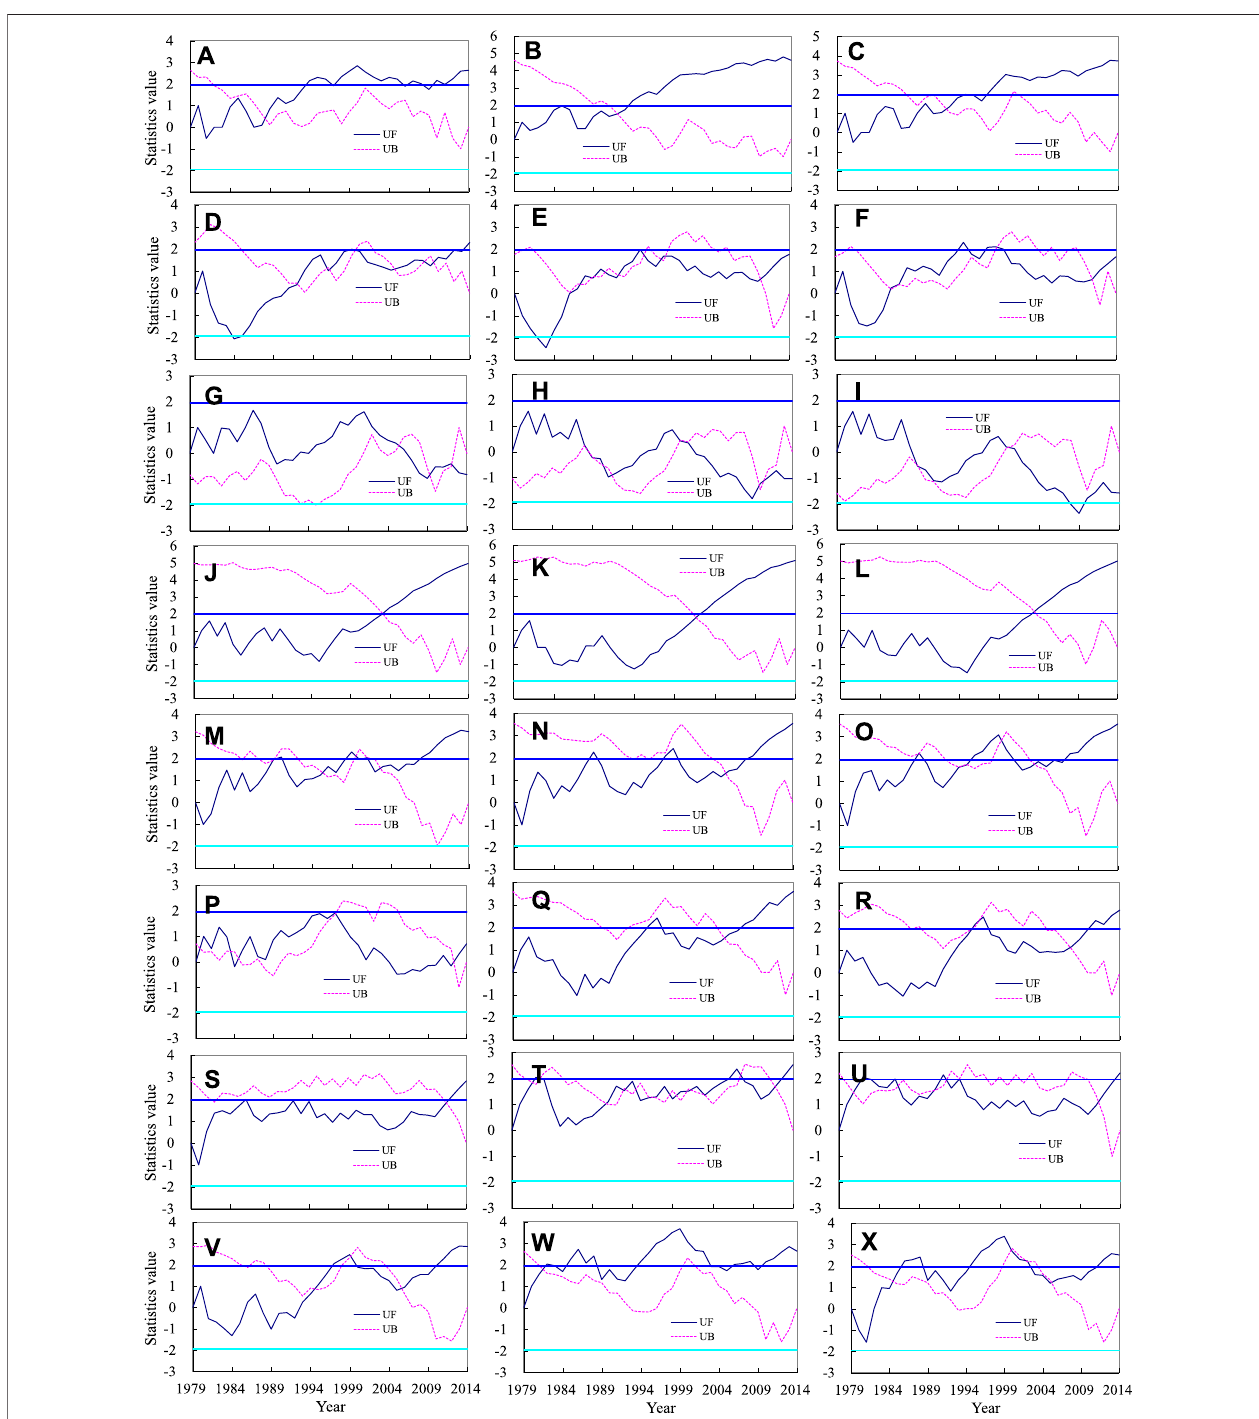
FIGURE 11 | M-K test of the WPD (left), EWSO (middle), and RLO (right) in the tropical Indian Ocean (A – C) , extratropical south Indian (D – F) , extratropical North Paci fi c (G – I) , tropical Paci fi c Ocean (J – L) , extratropical South Paci fi c (M – O) , extratropical North Atlantic (P – R) , tropical Atlantic Ocean (S – U) , and extratropical South Atlantic (V – X)